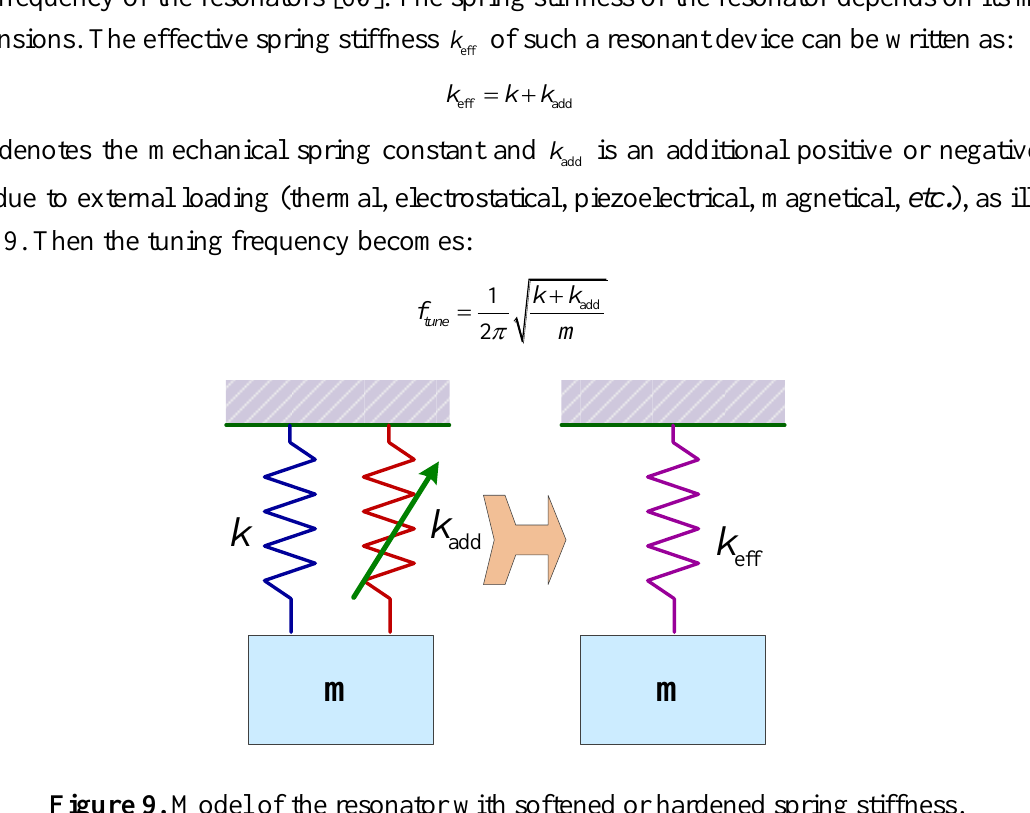
Figure 9. Model of the resonator with softened or hardened spring